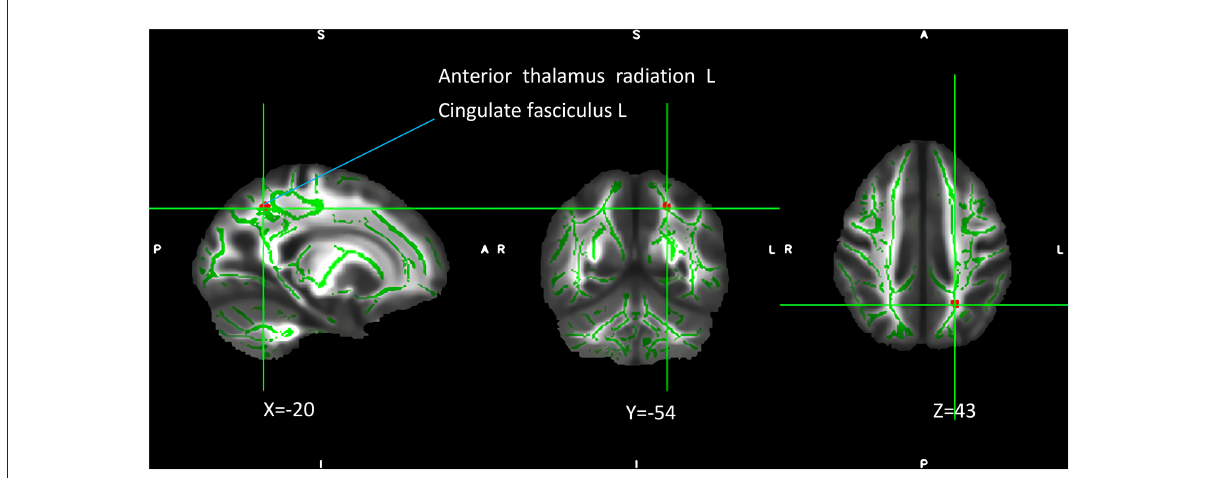
FIGURE1 Interaction of genotype and diagnosis on FA among the four groups. The green regions indicate FA white matter skeletons. Red-yellow regions indicate significantly different FA values between the four groups. All statistical maps were thresholded at P < 0.05 (after TFCE correction for multiple